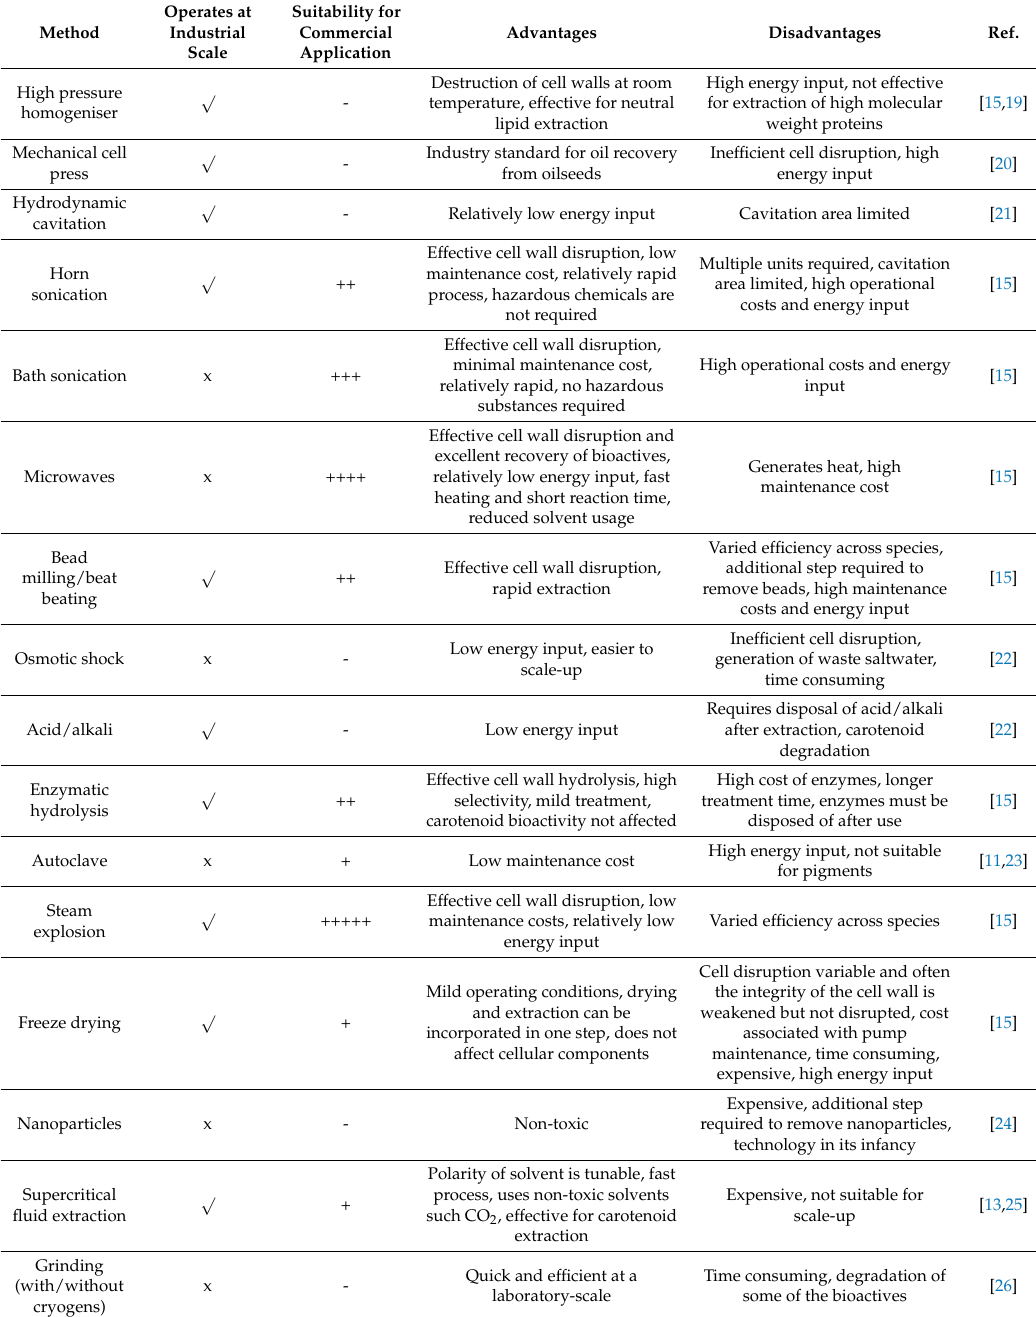
Table 1. Advantages and disadvantages of current cell disruption techniques for microalgal